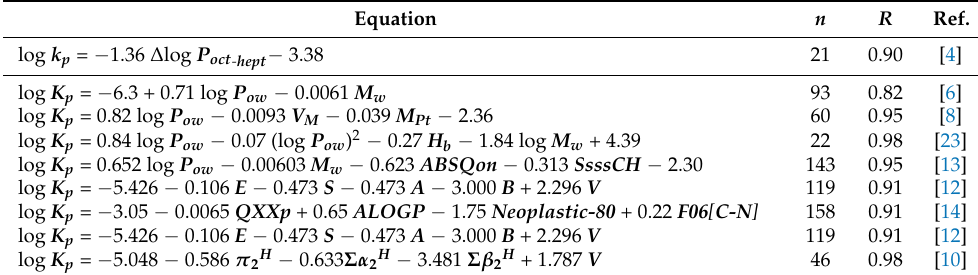
Table 1. Selected computational models of skin permeation. Equation n R Ref.